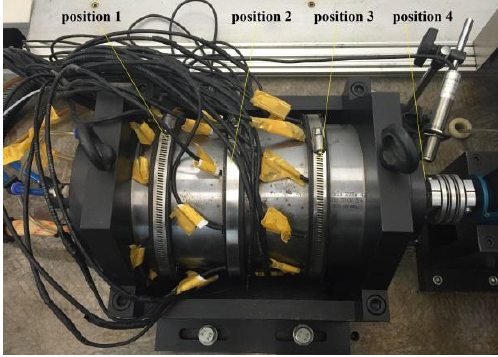
Figure 7. Arrangement of temperature test positions.